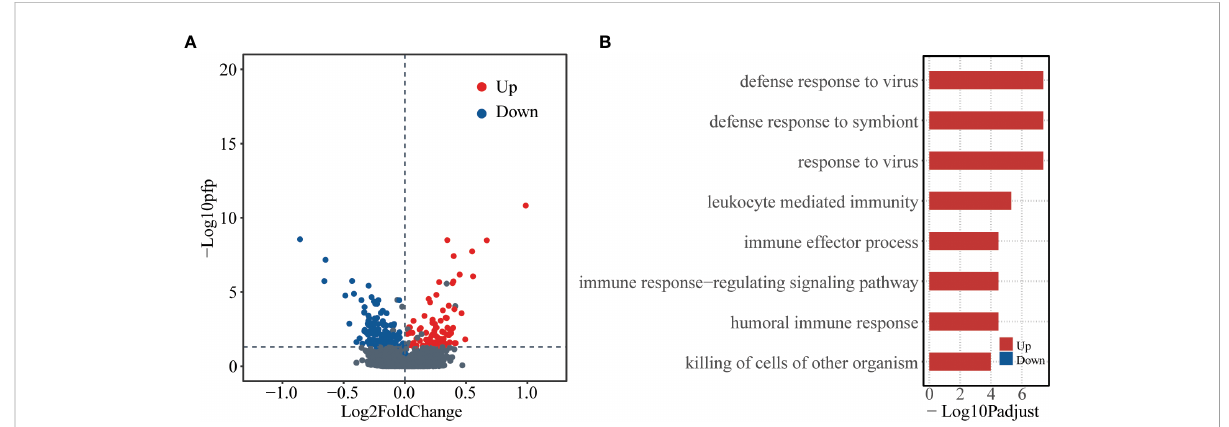
FIGURE 1 Differentially expressed genes at baseline level between asymptomatic and symptomatic hosts. (A) Volcano plot showing logarithmically converted fold change of gene expression between asymptomatic and symptomatic hosts on the x-axis against logarithmically converted values of pfp on the y-axis. The red points are up-regulated genes, and the blue points are down-regulated genes and the grey points are stable genes (asymptomatic vs symptomatic hosts). (B) Bar plot showing the GO biological process terms enriched for the up- (red) and down- (blue) regulated genes. The x-axis represents the logarithmically transformed Padjust